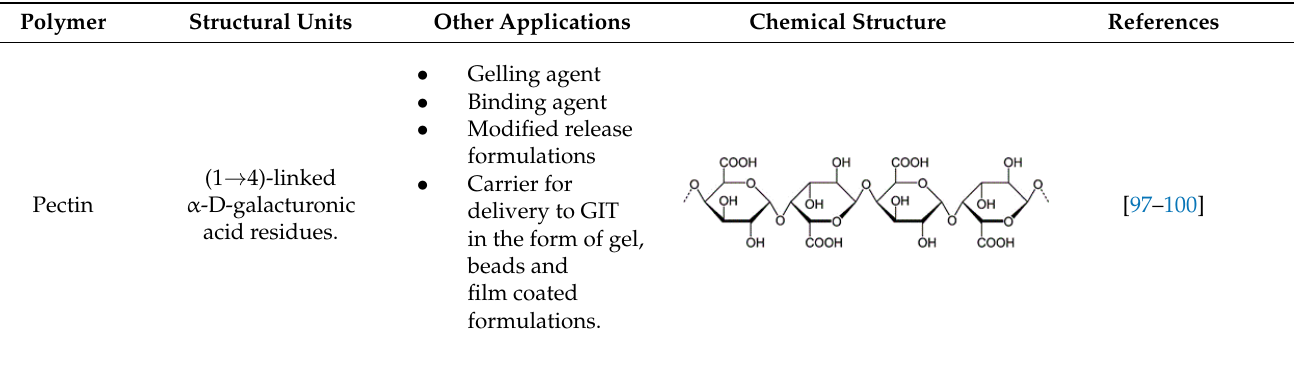
Table 1. Carbohydrate-based polymers: their structural units and pharmaceutical applications.